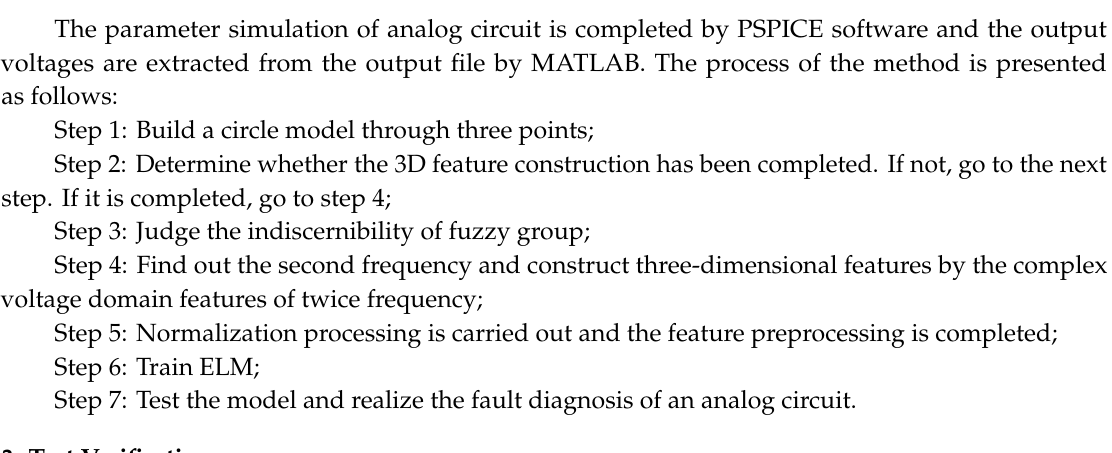
Table 3. The training and test results of different activation functions.